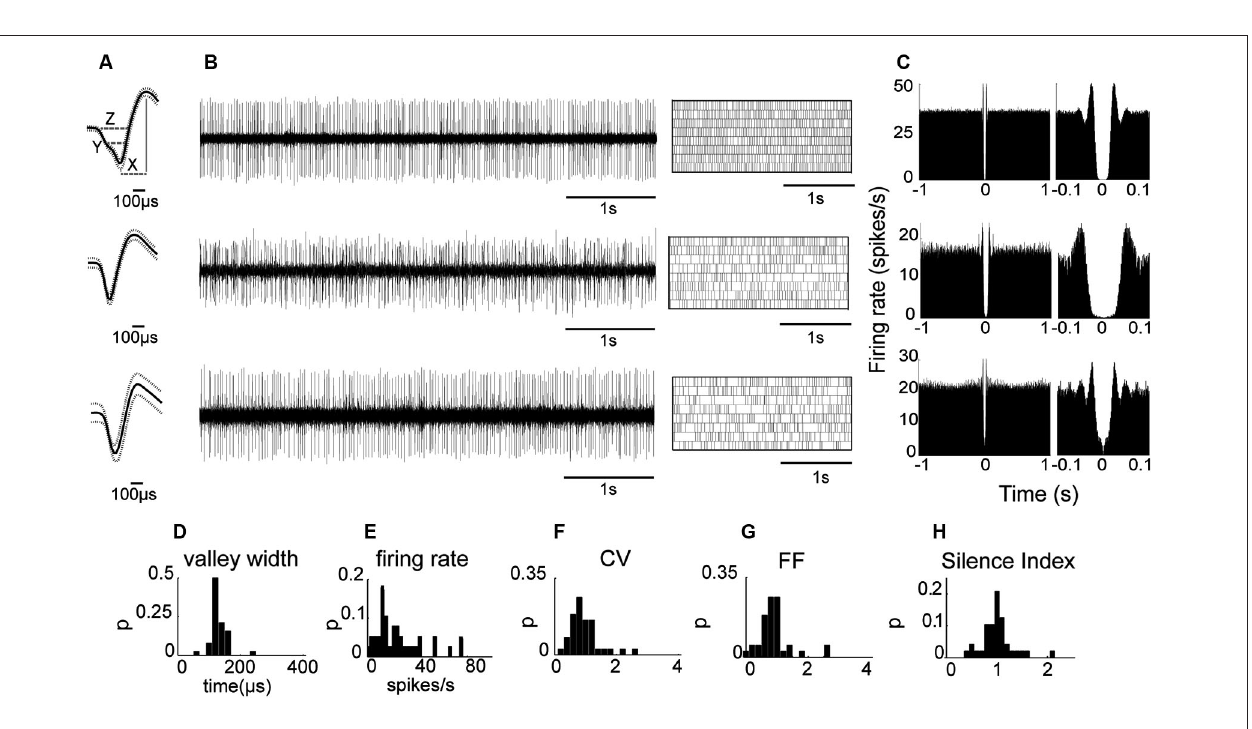
suggested that EP neurons ceased firing for durations longer than expected from irregular Poisson firing. Indeed, the Silence Index measured during isoflurane administration (1.51 ± 0.09) was substantially higher than during wakefulness (1.06 ± 0.05; Figure 3D ; p = 0.048). An example of the ISI histogram of one EP neuron is shown during anesthesia and wakefulness and illustrates the long tail of ISI observed under anesthe- sia ( Figure 3F ). The FF values within the population did not change with isoflurane administration ( Figure 3C ; p = 0.75), and the neuronal pairwise interactions ( n = 24) continued to be